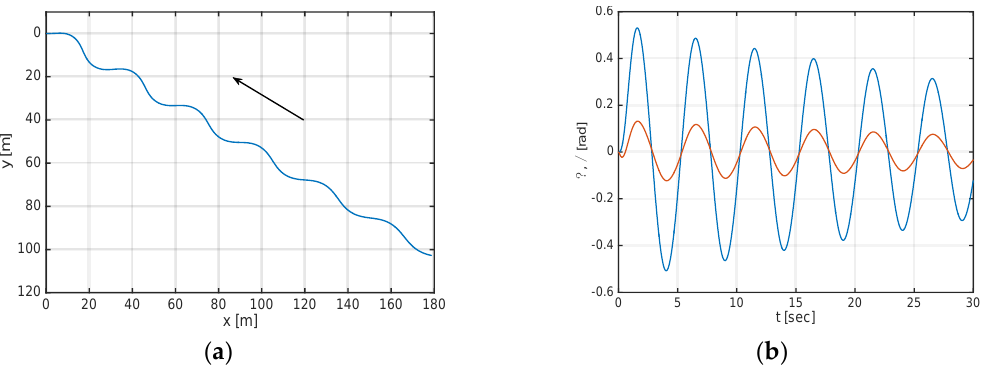
Figure 4. Time series of an uncontrolled bicycle running a constant forward speed of 7.34 m/s against a cross wind of 8.0 m/s at 30 degrees (Beaufort 5, fresh breeze); ( a ) path of the rear wheel contact point (arrow indicates the wind direction) ( b ) bicycle roll angle (blue) and steer angle (red) as a function of